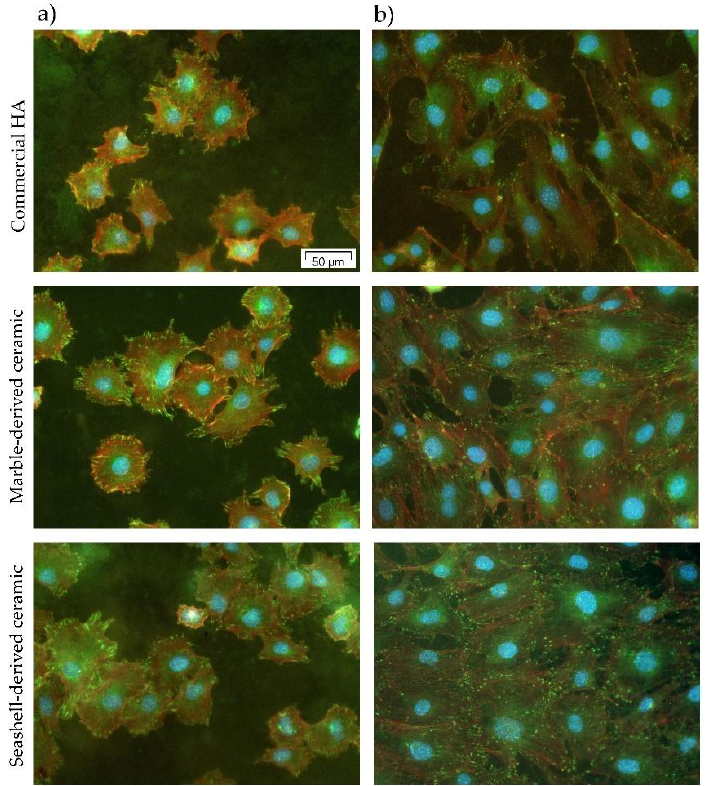
Figure 7. Merged fluorescence micrographs of actin cytoskeleton (red) and vinculin immunoreactive sites (green) in MC3T3-E1 pre-osteoblasts grown on commercial HA, marble- and seashell-derived ceramics for 3 h ( a ) and 24 h ( b ). The nuclei are labeled with DAPI (blue). Scale bar: 50 μm.